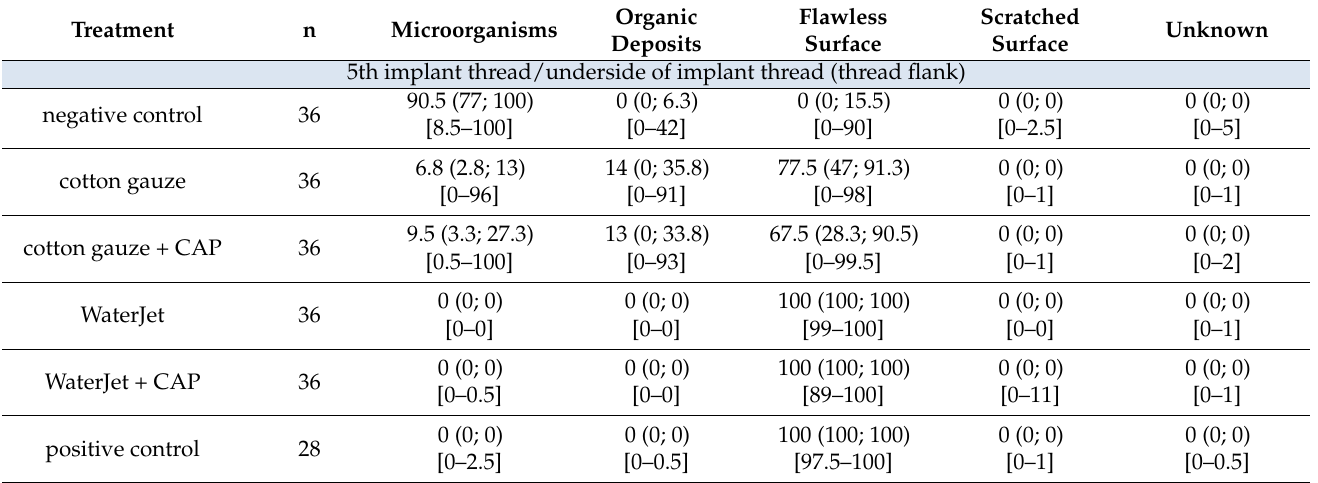
Table A4. Median percentages of cross points with microorganisms, organic deposits, flawless surface, scratched surface, and unknown by treatment for all combinations of implant thread (3rd and 5th) and side of implant thread (underside and above). Data are presented as median (25% percentile; 75% percentile) and [min–max]. CAP, cold atmospheric pressure